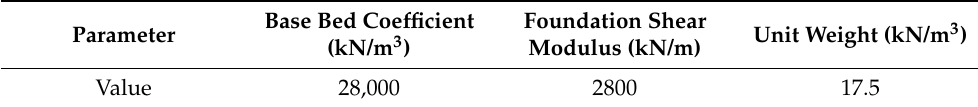
Table 1. Mechanical parameters of the surrounding